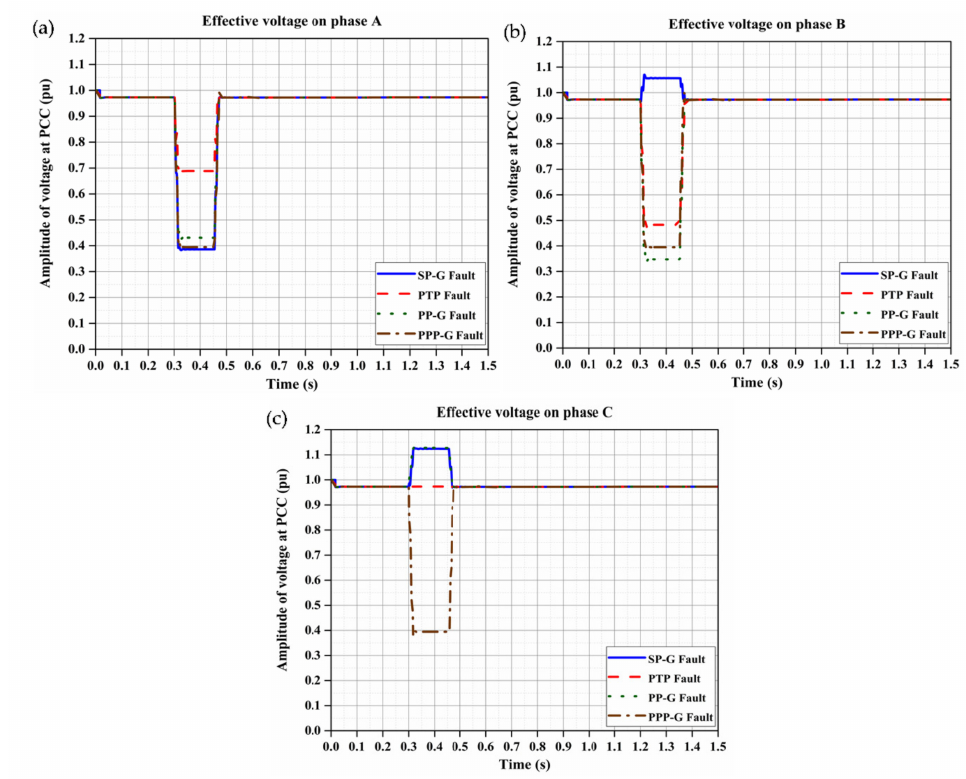
Figure 4. ( a – c ) The changes of e ff ective values of the PCC voltage during grid fault conditions in di ff erent phases.